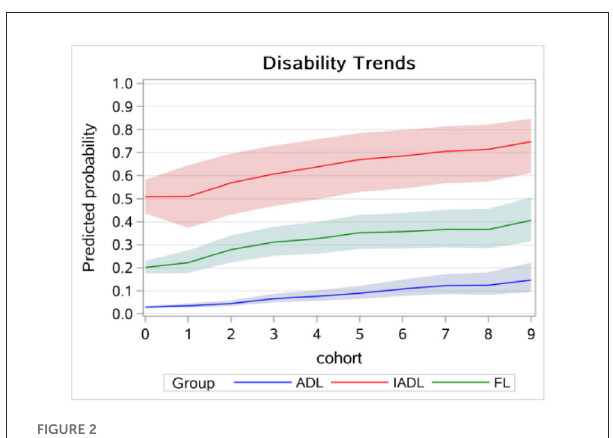
FIGURE2 Cohort trends in disabilities among older